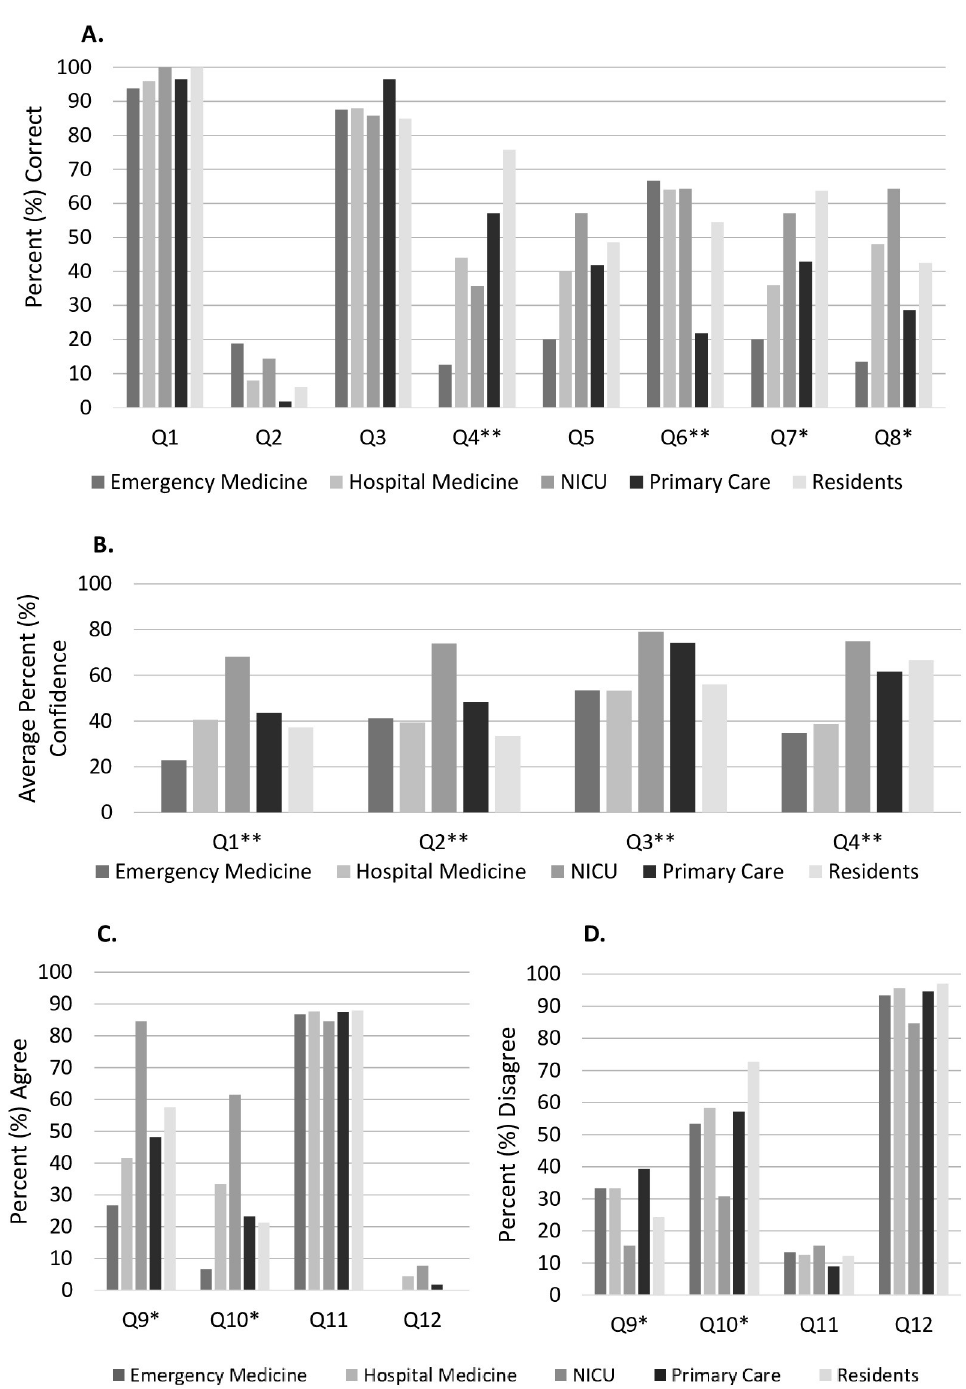
Fig 2. Graphical representation of survey responses by specialty of respondent. A. Percent Correct Response Rate by Specialty for Knowledge Questions. B. Average Self-Reported Percent Confidence by Specialty. C. Percent Agree [Strongly Agree + Somewhat Agree] with Described Management by Specialty. D. Percent Disagree [Strongly Disagree + Somewhat Disagree with Described Management by Specialty. � denotes p < 0 . 05 , �� denotes p < 0 . 001 .